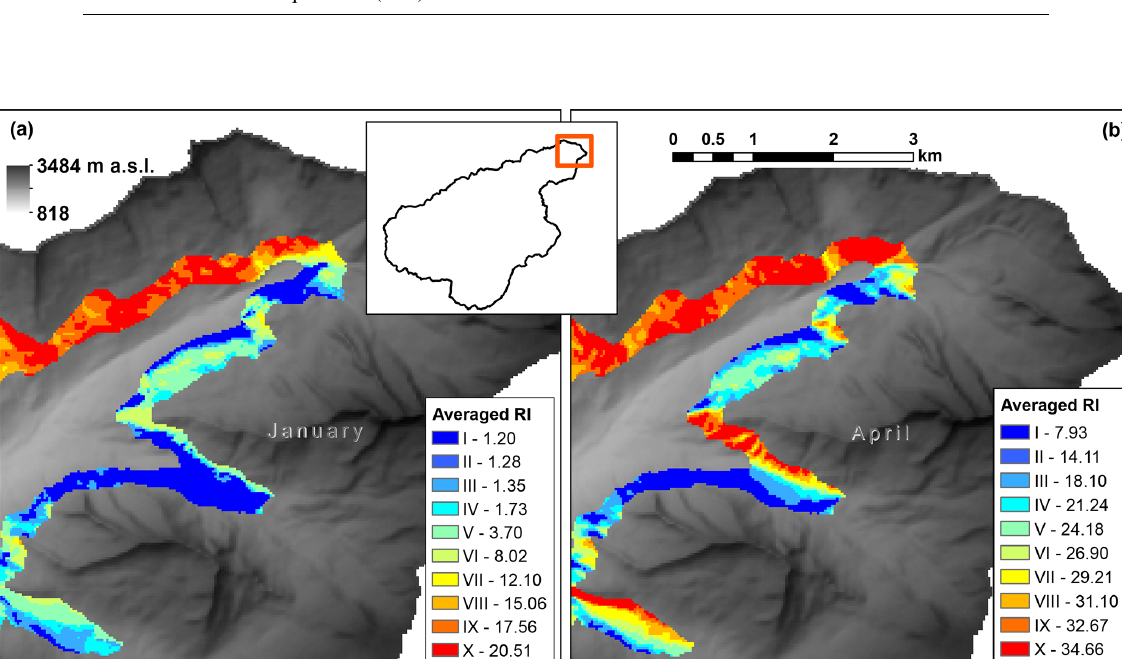
Figure 1. Comparison between radiation index distribution over the 2000–2200m elevation band of the Aurino Basin for (a) 1 January and (b) 1 April (10 subdivision classes). The figures show the north-eastern portion of the basin and report the average radiation index M (Jm − 2 ), with the corresponding radiation class identified by a roman